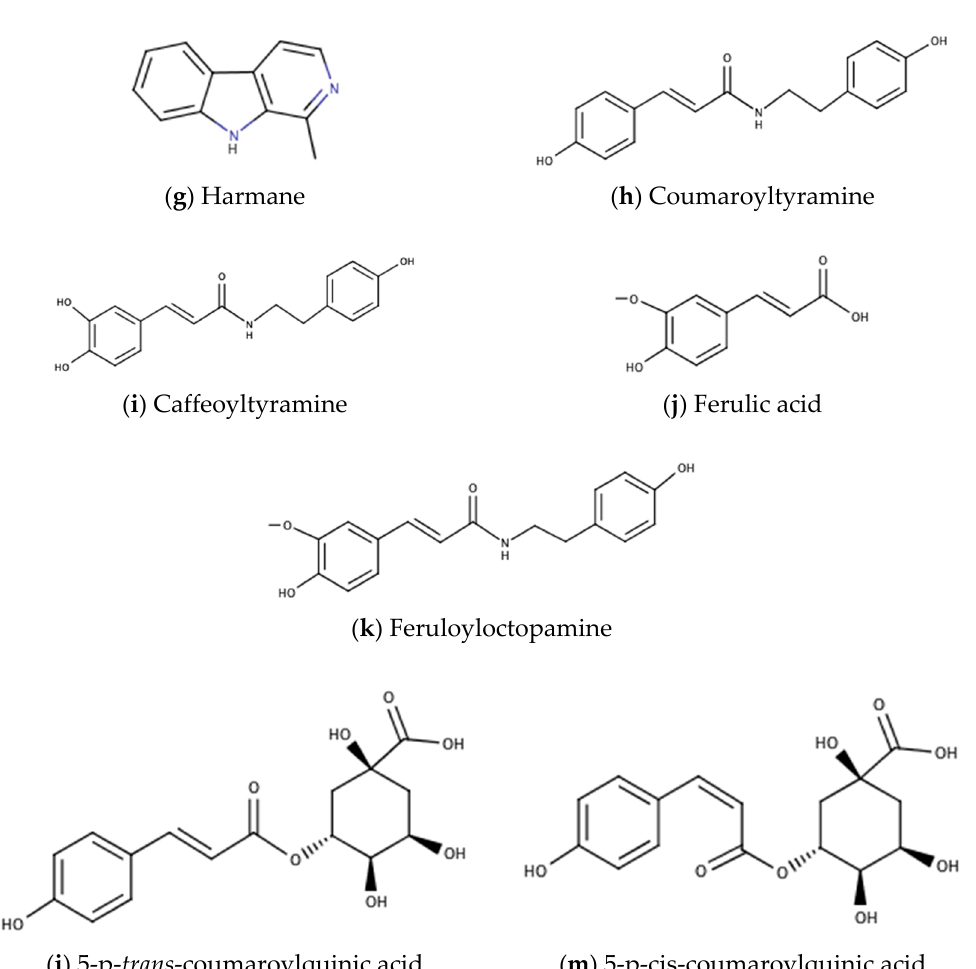
Figure 2. The most common compounds found in TT extracts.